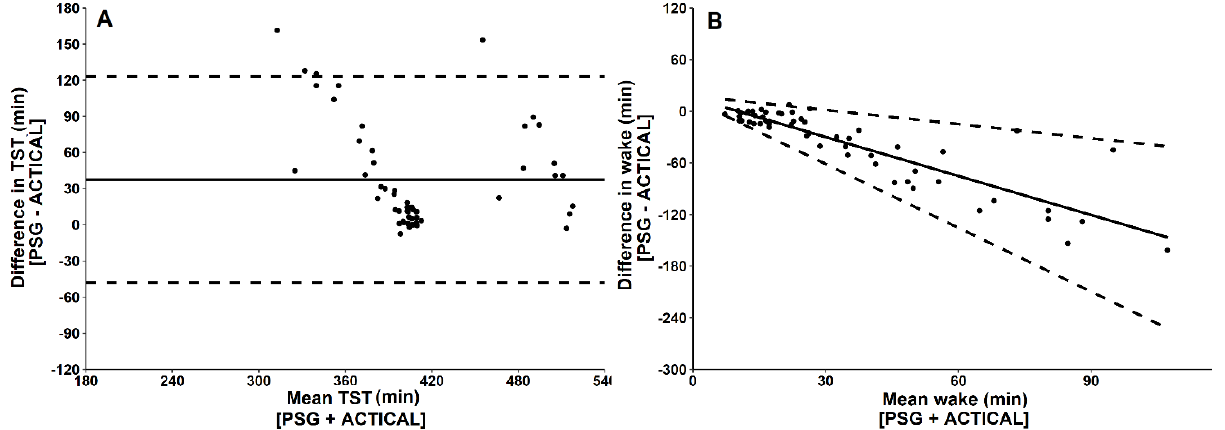
Figure 4. Bland–Altman plots for ACTICAL and PSG-derived measures of ( A ) total sleep time (TST) and ( B ) wake time. Data points represent one sleep opportunity. The x-axes represent the mean of the values obtained from ACTICAL and PSG. The y-axes represent the difference between the values, such that positive values indicate that ACTICAL overestimates relative to PSG and negative values indicate that ACTICAL underestimates relative to PSG. Solid horizontal lines indicate the mean bias from PSG, and broken lines indicate the 95% limits of agreement (±1.96 standard deviations) [20].